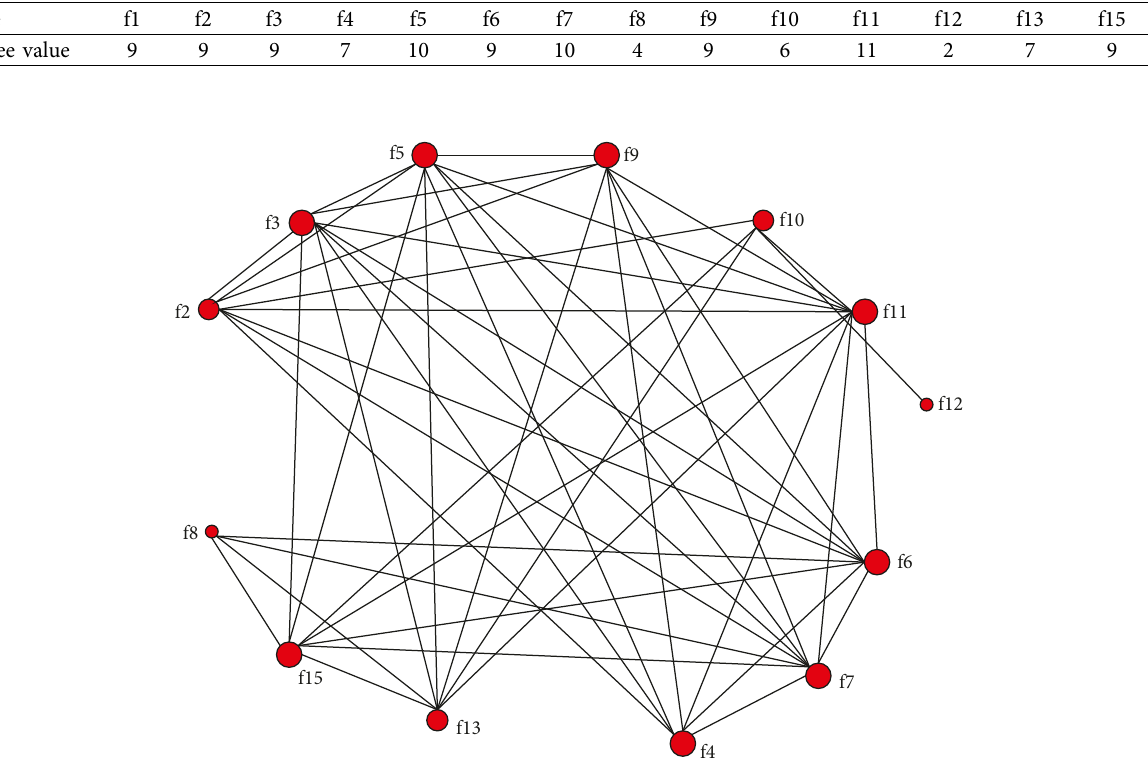
Figure 2: Network topology diagram where f 1